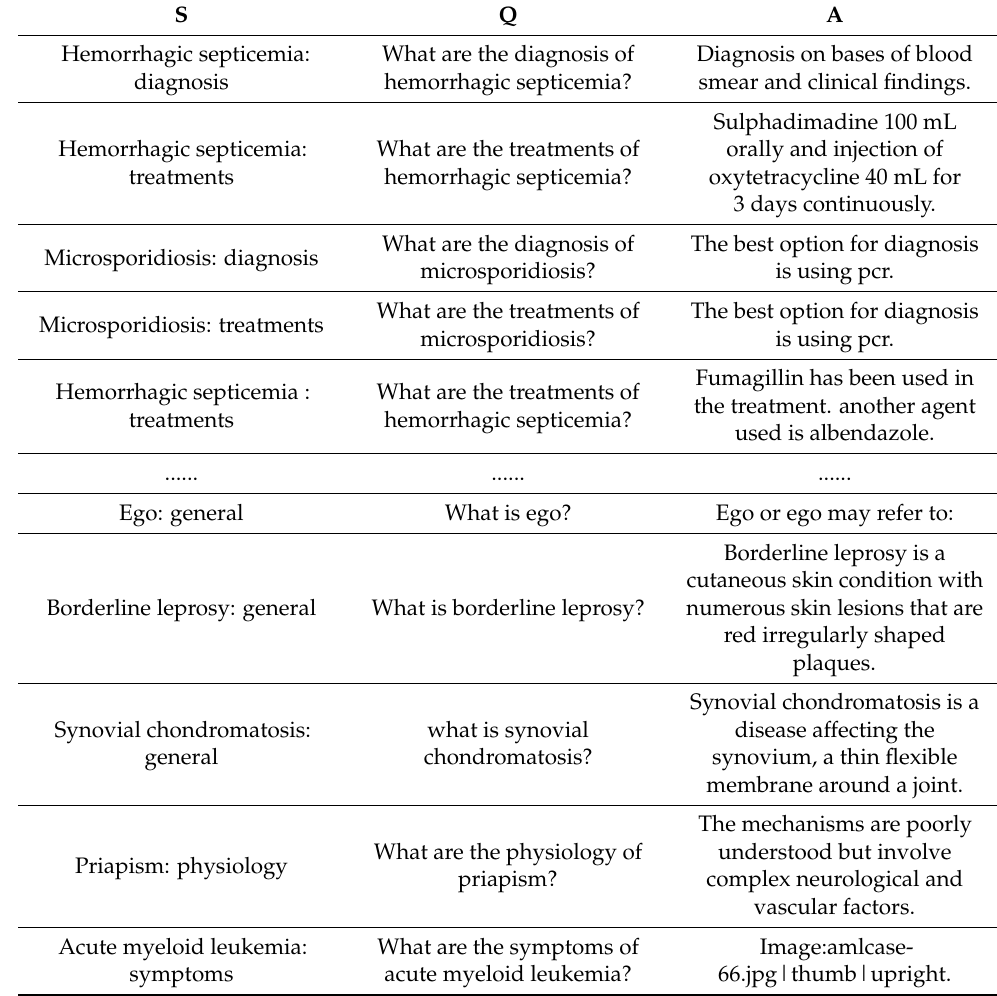
Table 1. Disease knowledge dataset